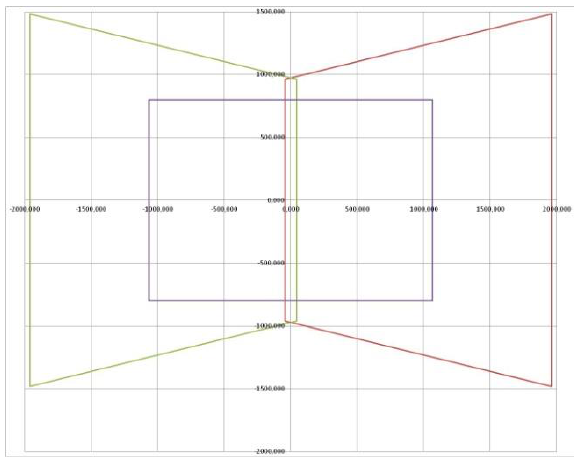
Figure 6. Camera footprints of the mid-altitude configuration, flight direction is